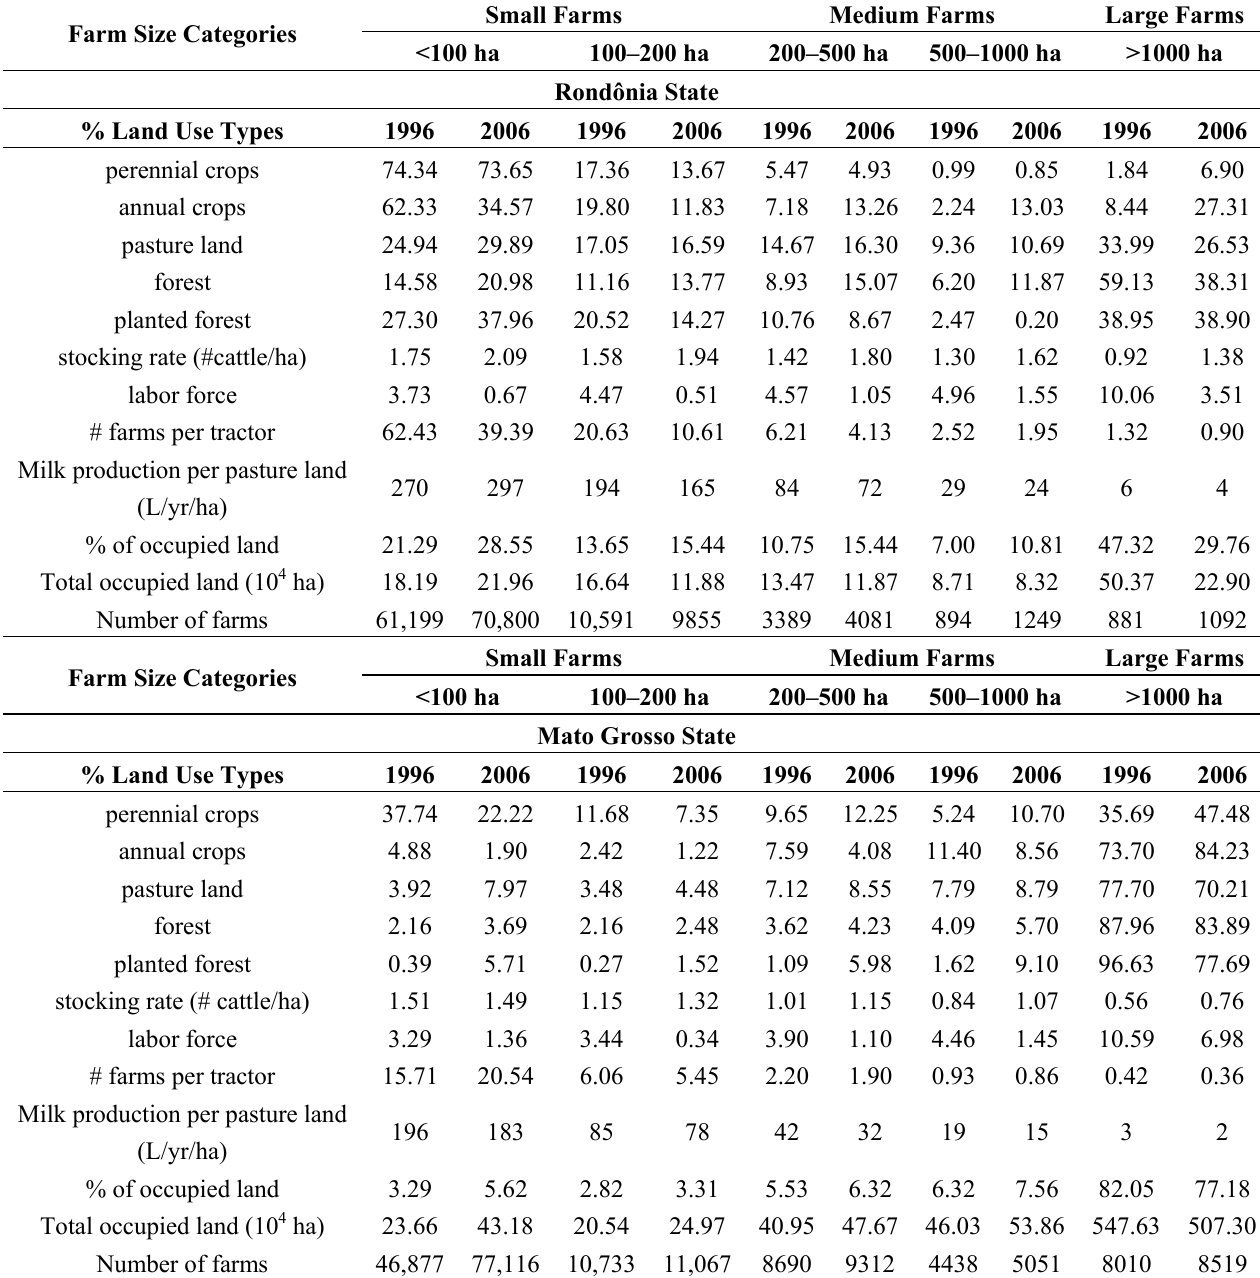
Table 3. Total occupied land area and fractions of the total occupied area used by different land use types, stocking rates, labor force, number of farms per tractor and milk production per farm in Rondônia and Mato Grosso states in 1996 and